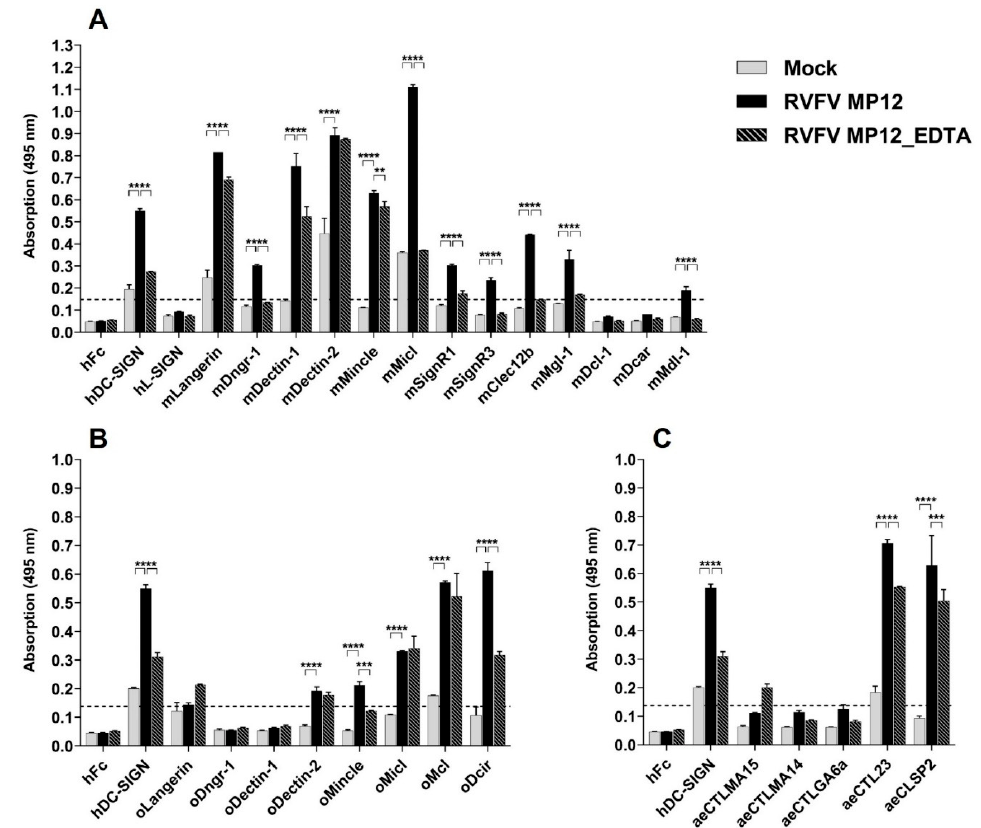
Figure 5. CLR–hFc fusion proteins across species bind to RVFV MP12: ( A ) ELISA-based binding study of purified RVFV MP12/Mock with murine CLR–hFc fusion proteins in the presence and ab- sence of EDTA. hDC-SIGN served as positive control [24,45] and hFc-empty as negative control. One representative of n = 5 (EDTA: n = 2) independent experiments is shown; ( B ) ELISA-based screening of purified RVFV MP12/Mock with ovine CLR–hFc fusion proteins, in the presence and absence of EDTA. hDC-SIGN served as positive control and hFc-empty as negative control. One representative of n = 3 (EDTA: n = 2) independent experiments is shown; ( C ) ELISA-based screening of purified RVFV MP12/Mock with Aedes aegypti CLR–hFc fusion proteins, in the presence and ab- sence of EDTA. hDC-SIGN served as positive control and hFc-empty as negative control. One rep- resentative of n = 3 (EDTA: n = 2) independent experiments is shown; ( A – C ) to discard possible false positives, the dotted line represents the cutoff defined as the threefold margin of the absorbance value relative to hFc, based on previous screenings with the CLR–hFc fusion protein library [34,46] . Data are depicted as mean + SEM of duplicates. One-way ANOVA with subsequent pairwise Tukey tests were performed to compare the binding of the CLR–hFc fusion proteins above the threshold to mock and the EDTA supplementation; ** p < 0.01, *** p < 0.0005, **** p < 0.0001. 3. Discussion Myeloid CLRs play important roles in virus recognition, resulting in diverse immune responses or host cell entry [17]. In this study, we used murine and ovine CLR–hFc fusion proteins [33–35] to identify RVFV binding candidates and compared the binding of CLR homologues in a cross-species approach. Since only human DC-SIGN and L-SIGN were previously reported to interact with RVFV and subsequently facilitate viral host cell entry [24,45], the role of many mammalian CLRs in RVFV recognition has not been investigated so far. Murine Langerin, Dectin-1, Dectin-2, Mincle, and Micl (Clec12a) seem to be CLR- binding candidates for RVFV (Figure 5A). Except for Langerin, their role in viral